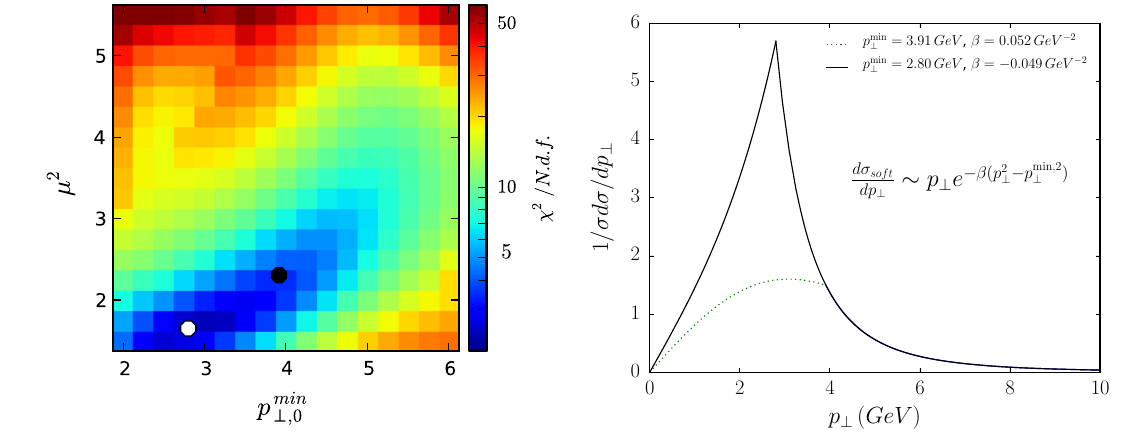
Fig. 5 Left panel: the weighted χ 2 / N . d . f . as a function of μ 2 and p min ⊥ , from [10]. The best fit point is shown with a white dot (tune Var2) 0 and a black dot (tune Var1) represents a good fit with higher p min ⊥ ,